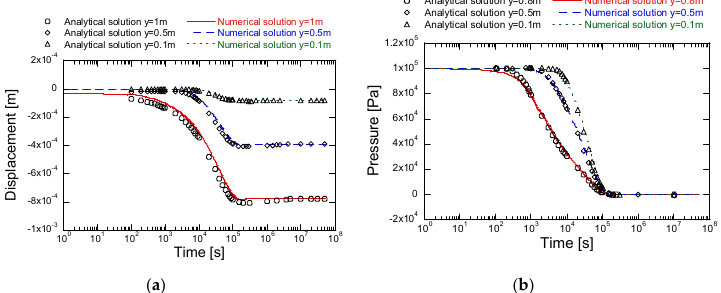
Figure 11. Comparison of analytical and numerical solution in the soil column at different positions: ( a ) displacement; ( b ) pore pressure.